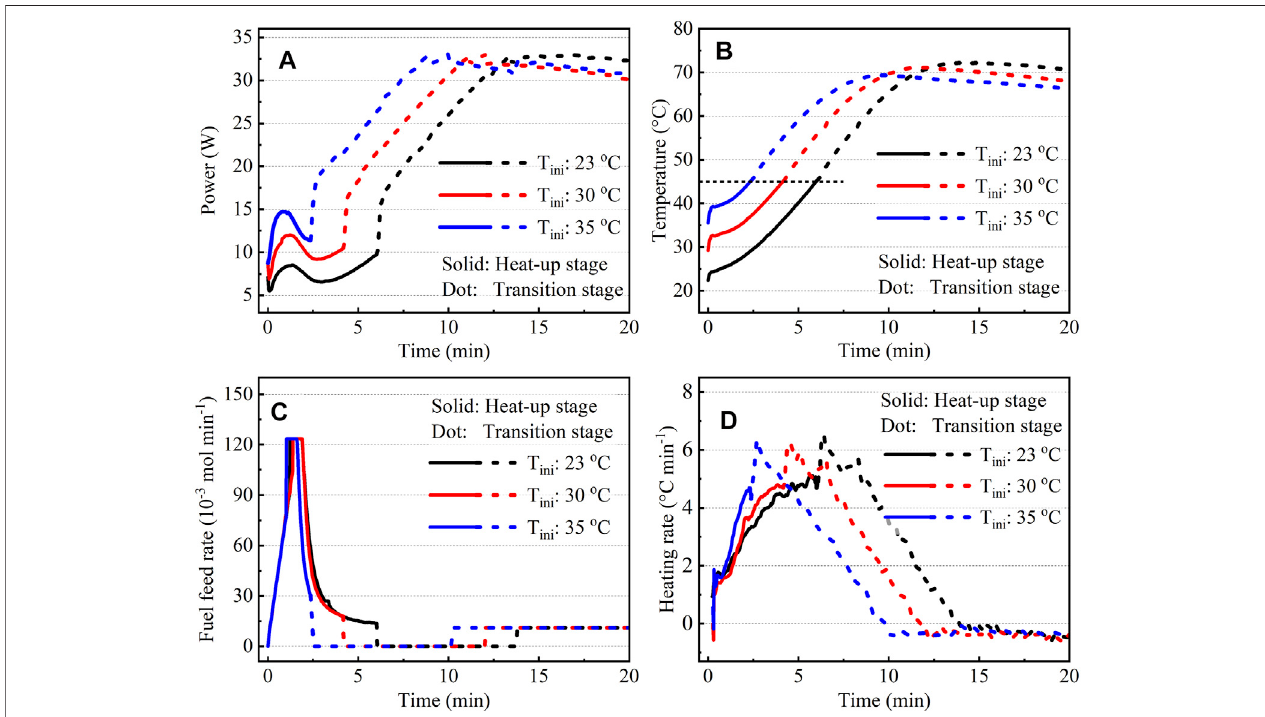
FIGURE4| Pro fi lesofthe (A) power, (B) temperature, (C) fuelfeedrate,and (D) temperaturerisingrateoftheDMFCduringstartupsatvariousinitialtemperatures. C ini : 0.5 mol L − 1 .